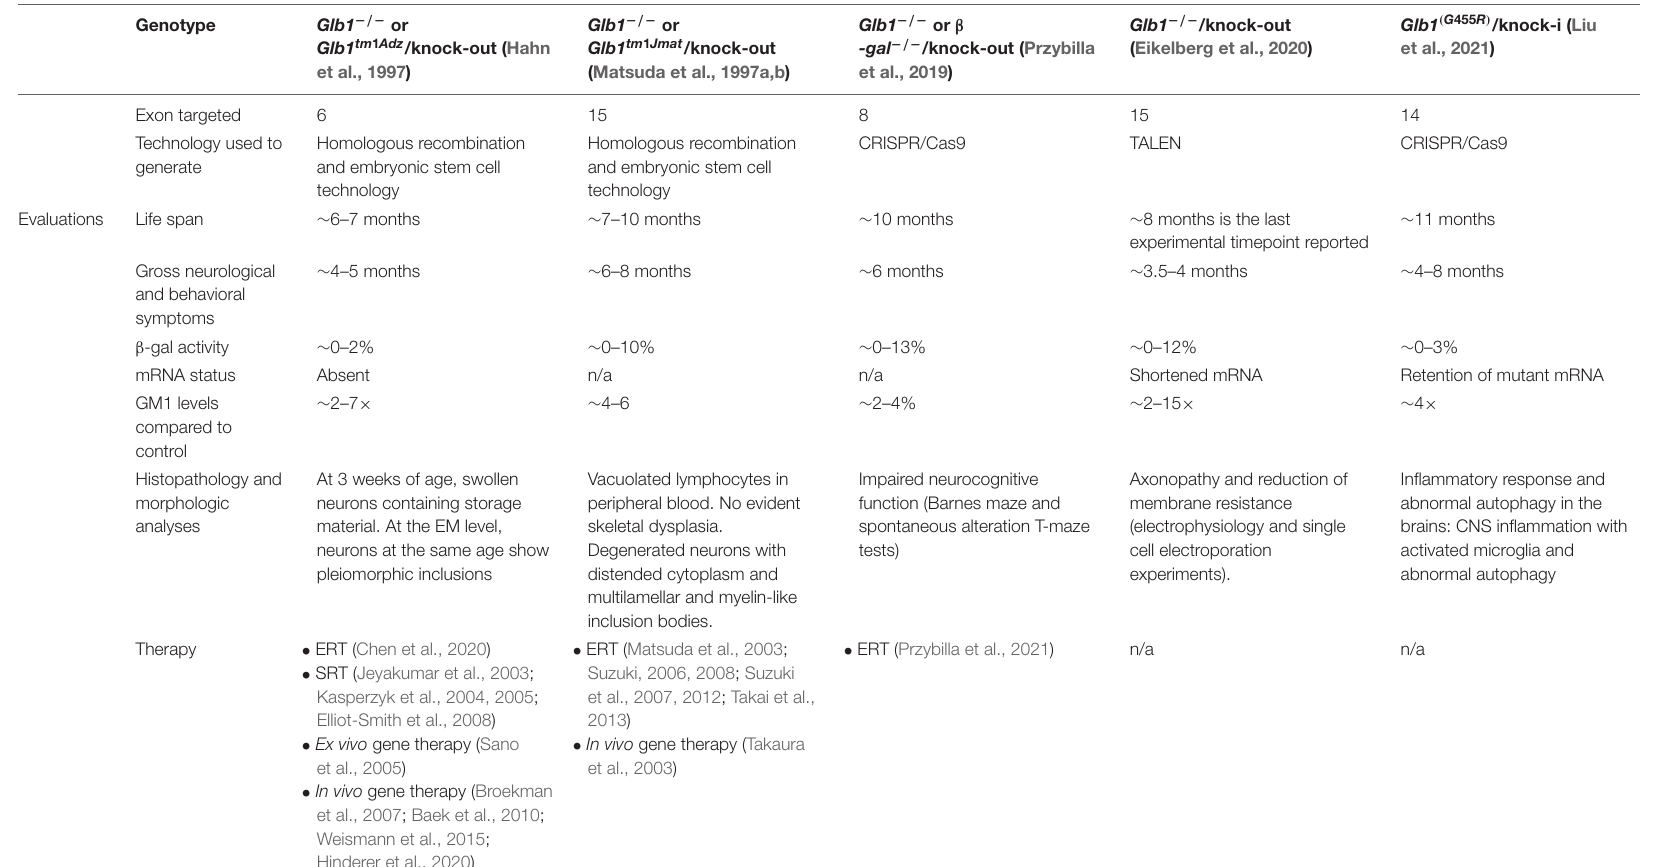
TABLE 1 | Overview of developed GM1 gangliosidosis mouse models: characteristics and therapies tested. Genotype